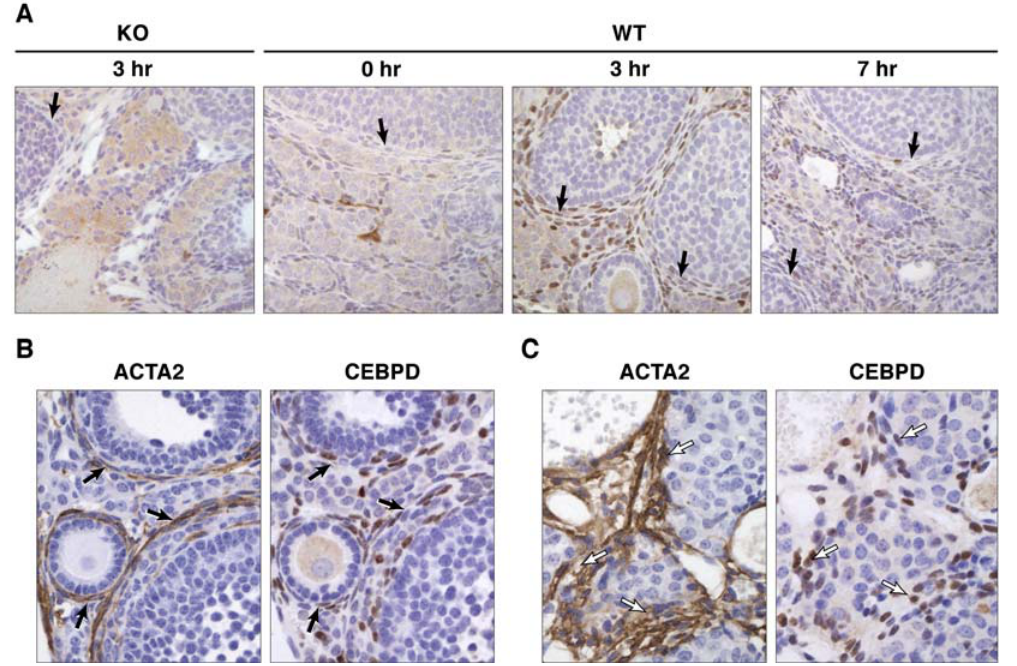
Figure 4. CEBPD protein expression in mouse ovaries. (A) Immunohistochemistry for CEBPD in ovaries from wild-type (WT) or Cebpd null mutant (KO) mice at the indicated time points following hCG treatment. (B, C) Immunohistochemistry for CEBPD and alpha smooth muscle actin (ACTA2) in wild-type ovaries harvested 3 h after hCG treatment. Solid arrows indicate theca layers (B), open arrows indicate stromal areas (C) expressing both CEBPD and ACTA2.